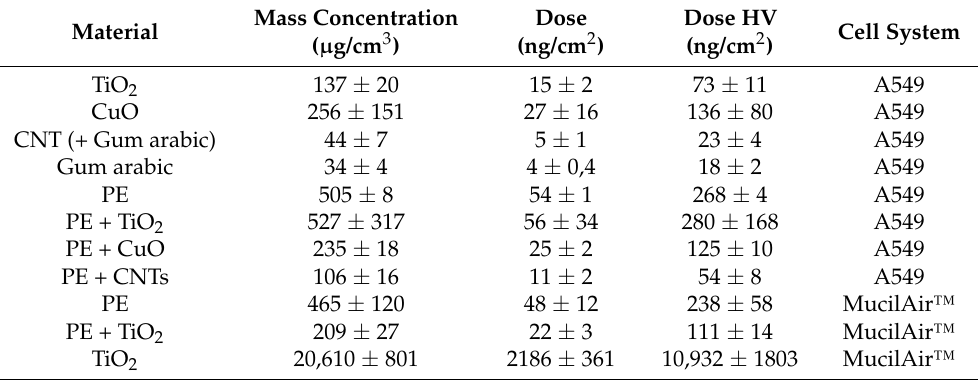
Table 1. Mass concentrations and applied doses for pure diffusional deposition (dose) and increased electrostatic deposition (dose HV, high voltage). Given are averages and standard deviation of three independently conducted